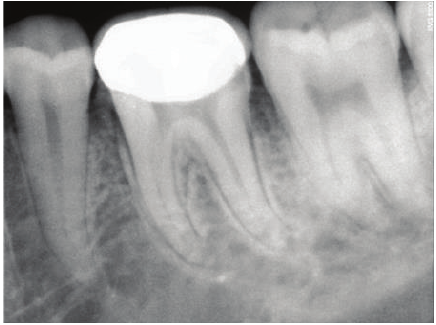
Figure 8: Immediate postoperative RVG.